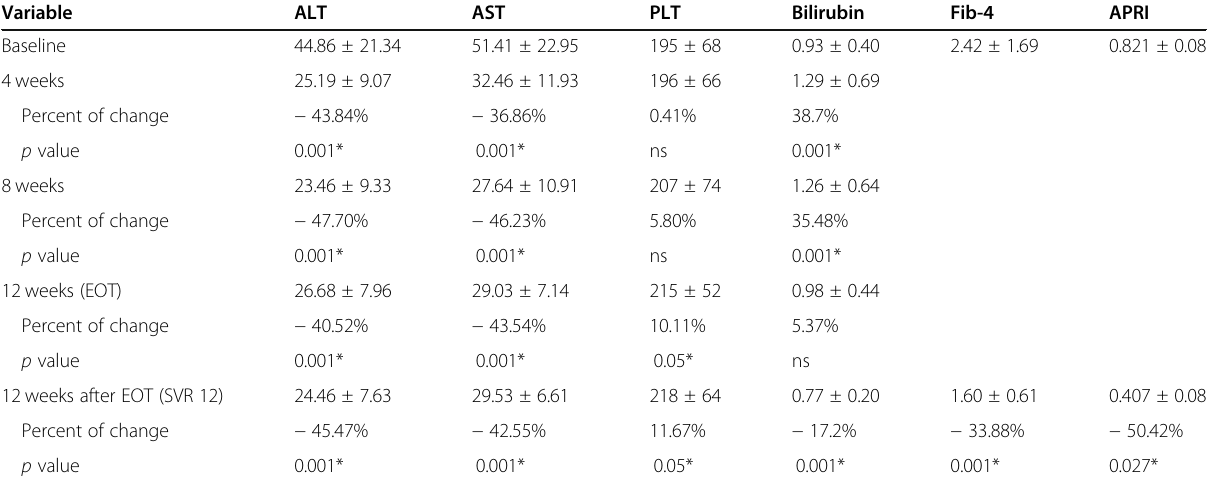
Table 3 Changes in the laboratory data of the study group Variable